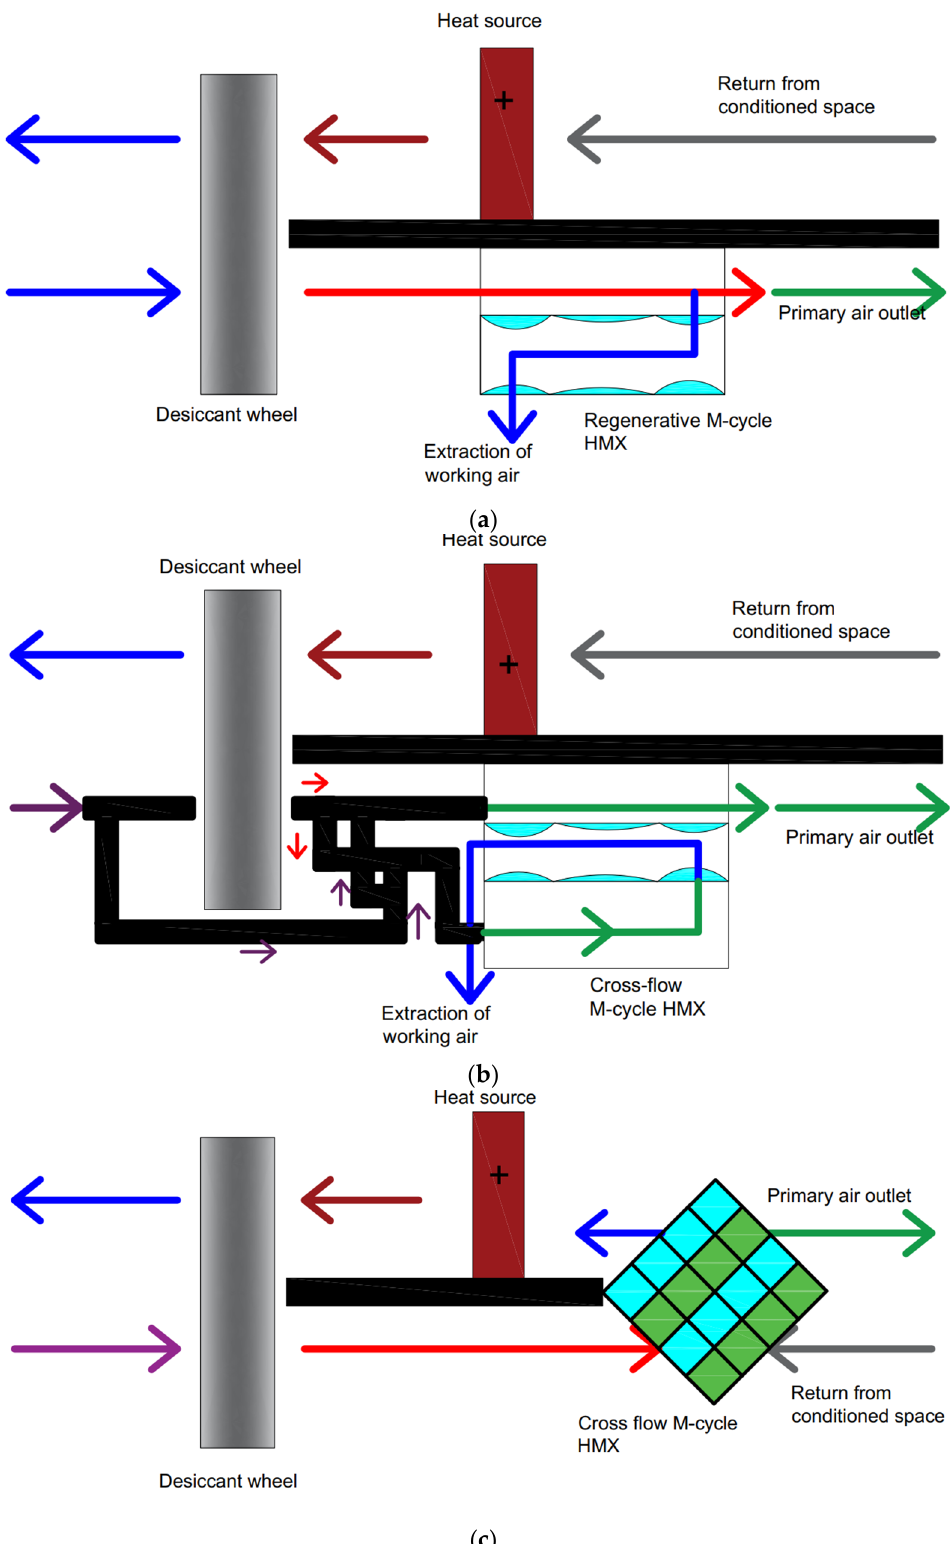
Figure 9. Different configurations of DAC with ( a ) regenerative M-cycle, ( b ) cross-flow M-cycle HMX, and ( c ) cross-flow M-cycle [58].